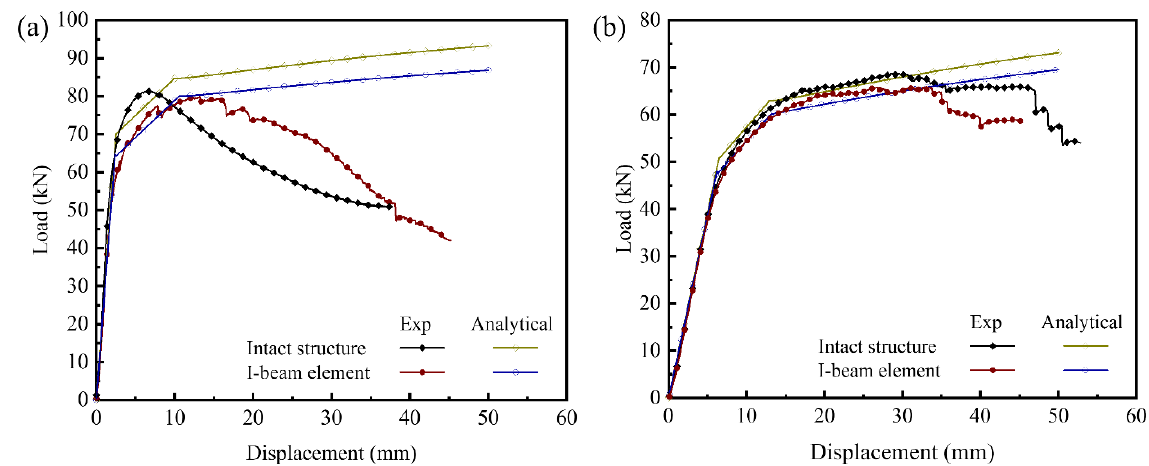
Figure 12. Load-displacement curves obtained from analytical model and experimental results under three-point bending ( a ) and four-point bending ( b ).